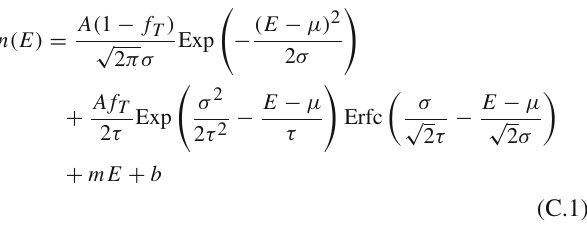
α event peak is highly non-Gaussian, as in Fig. 15b, because of the wide range of weighting potential values sampled by the source beam width at small radii. In these peaks, there is significantlow-energytailing,andanexponentially-modified Gaussian tail is included in the fit (see left inset of Fig.